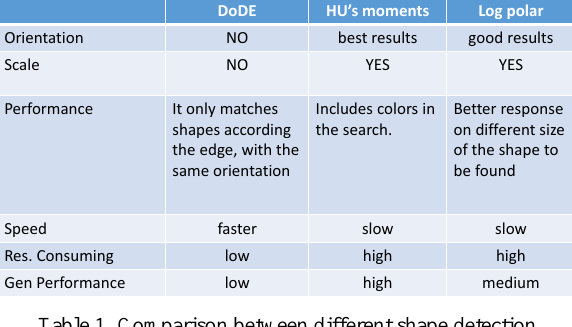
Table 1. Comparison between different shape detection